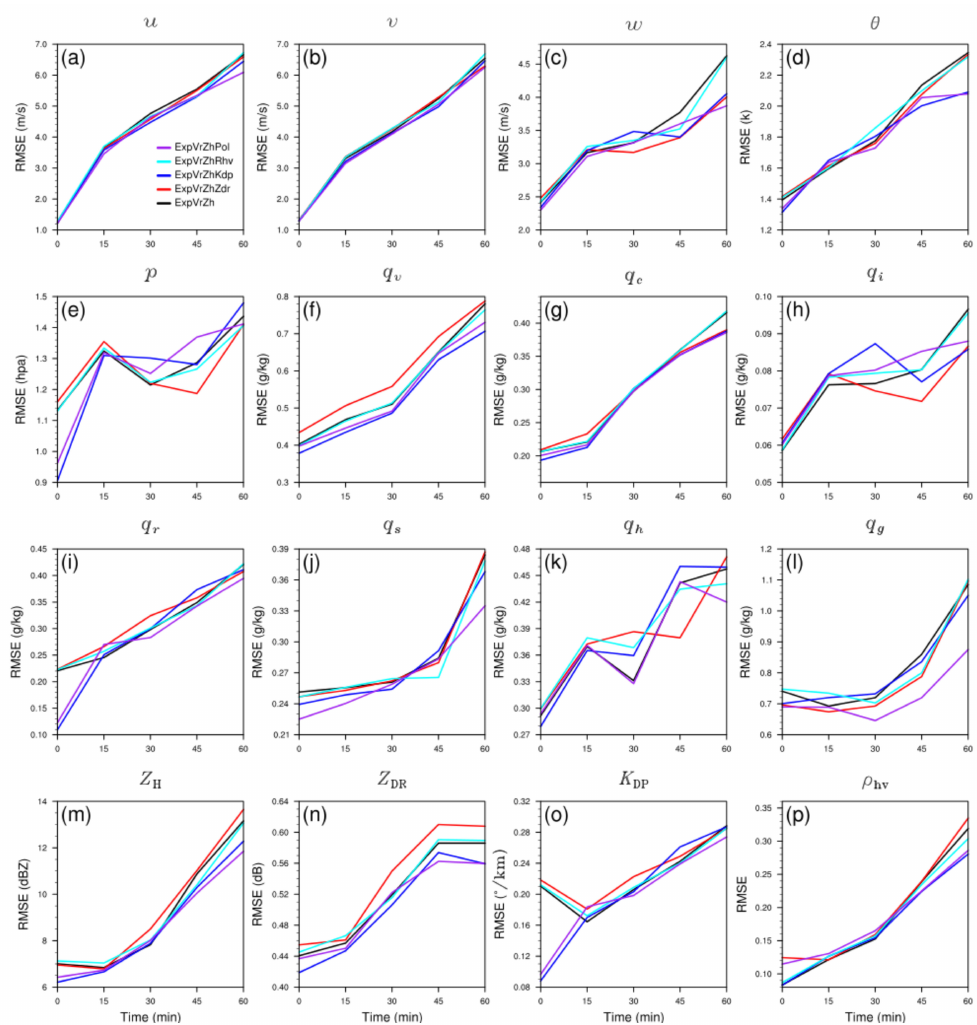
Figure 15. The mean RMSEs of 1 h forecasts at a 15 min intervals initiated at 120 min for ExpVrZh (black line), ExpVrZhZdr (red line), ExpVrZhKdp (blue line), ExpVrZhRhv (cyan line), and ExpVrZh- Pol (purple line), respectively, averaged over grid points with observed (simulated) Z H exceeding 10 dBZ. ( a ) u , ( b ) v , ( c ) w , ( d ) perturbation potential temperature θ , ( e ) perturbation pressure p , mixing ratios of ( f ) water vapor q v , ( g ) cloud water q c , ( h ) cloud ice q i , ( i ) rain water q r , ( j ) snow q s , ( k ) hail q h